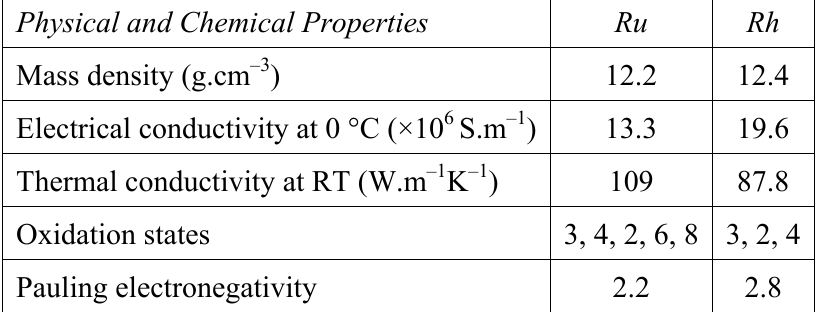
Table 1. Comparison of some physical and chemical properties of ruthenium and